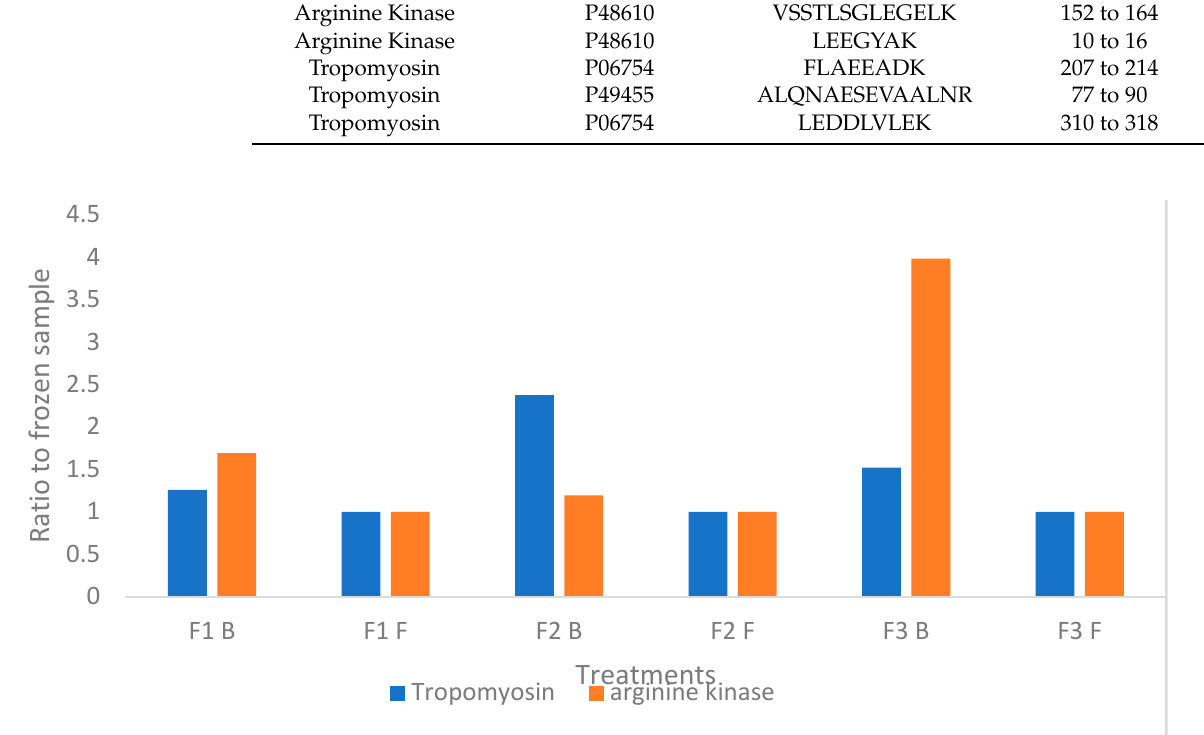
Figure 1. Liquid chromatography mass spectrometry (LC-MS) analysis of tropomyosin and arginine kinase in black soldier fly larvae extracts. Results represent means of three analyses and are a ratio relative to the frozen treatments. F1–Broiler-based diet; F2—Brewers grain (by-product); F3—Cere- als grain (by-product); B—Blanched, F—Frozen.